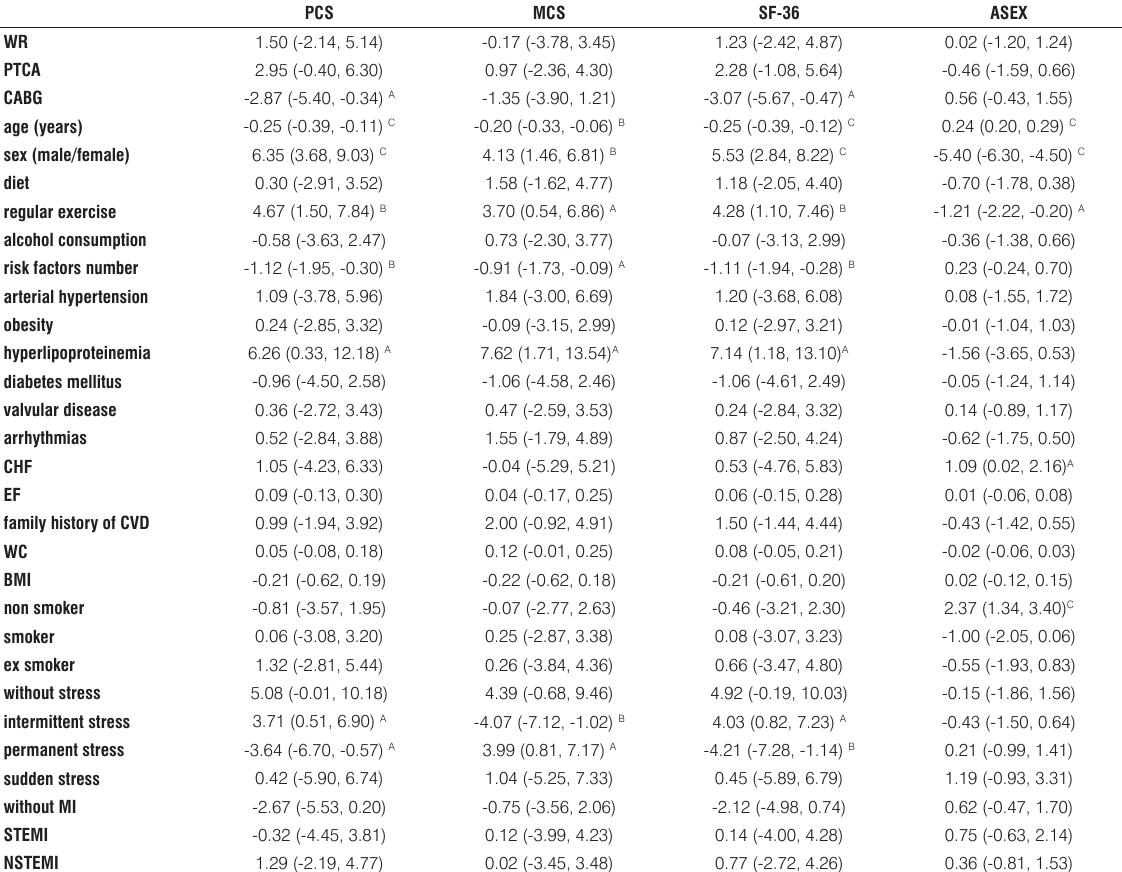
Table 7. Results of multivariate regression models: HRQoL and ASEX relations with variables considered in the study (regression coefficients and